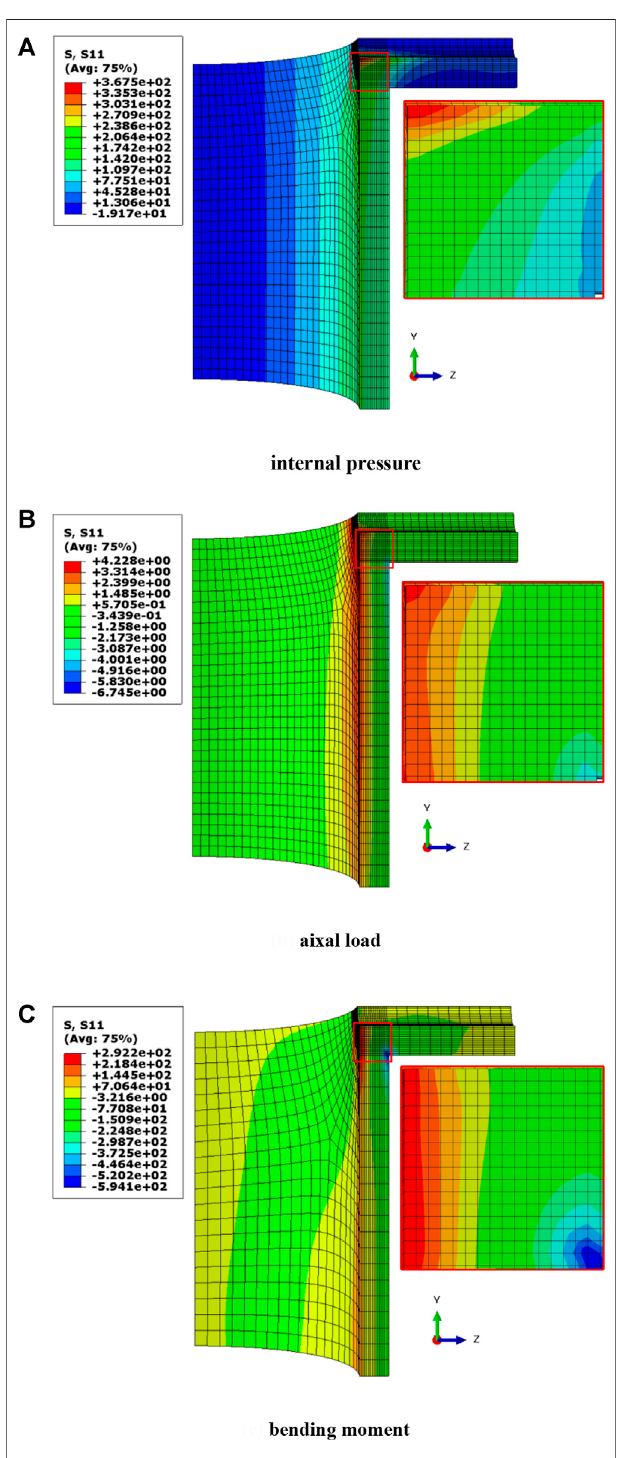
FIGURE 2 | Hoop stress contours in the nozzle corner